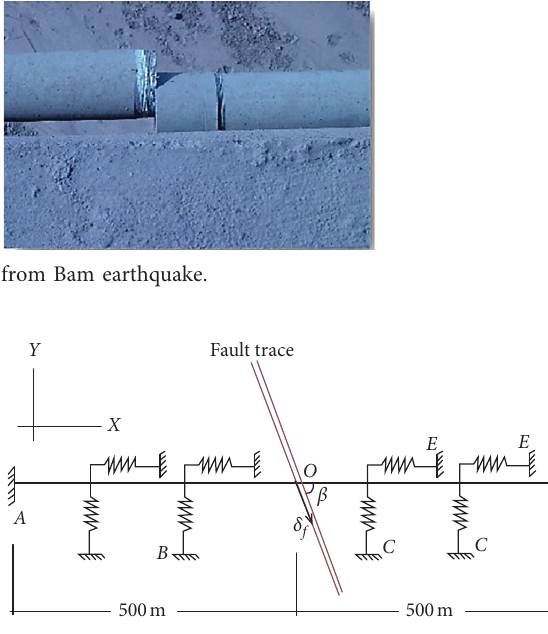
Figure 6: Ideal structural model during faulting.